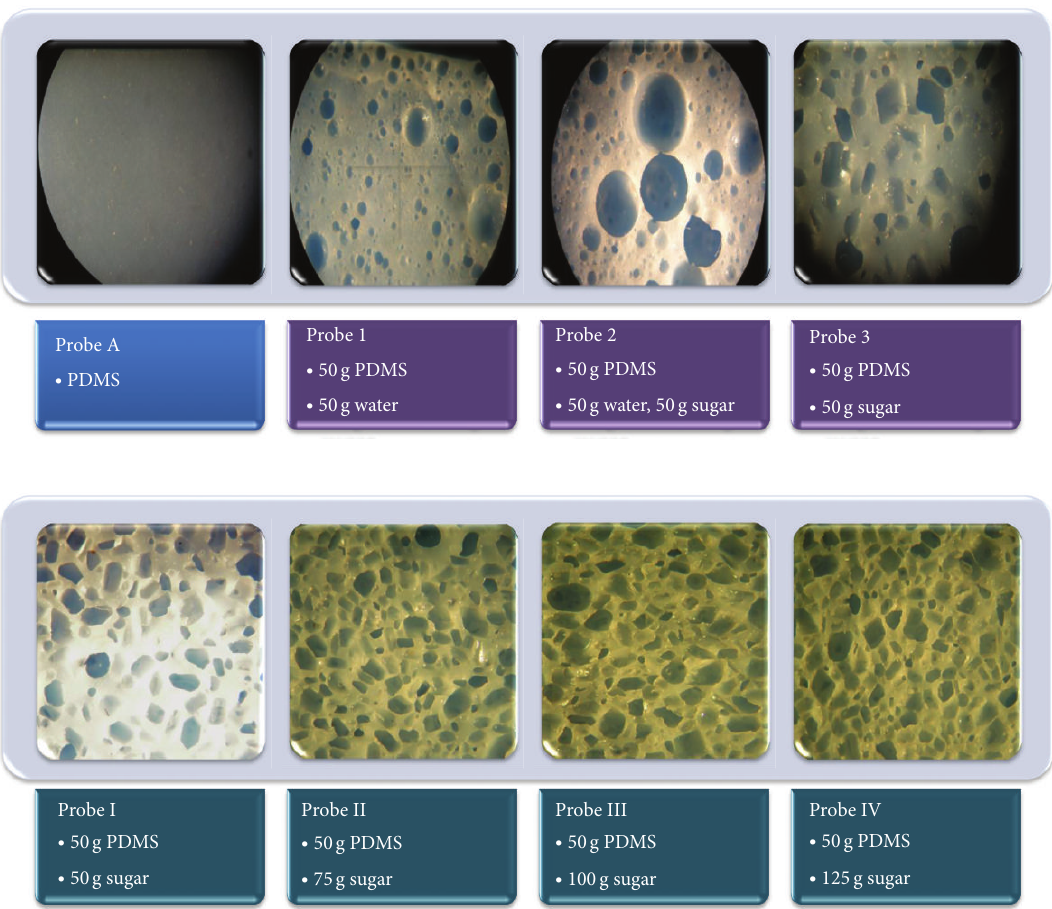
Figure 3: Different morphologies, after particle leaching and drying, obtained by systematic modification of the sugar and water content incorporated to the PDMS during the polymerization